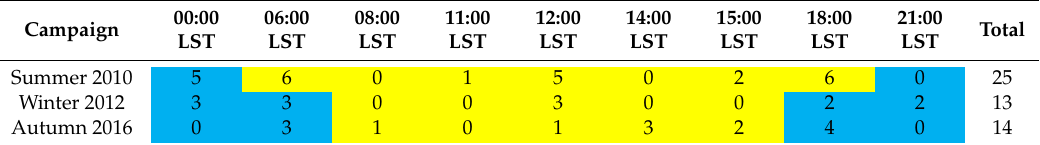
Table 1. Number and launching time of the soundings carried out during the campaigns. The color of the cells indicates the sunlight conditions during the radiosoundings (RS): yellow cells indicate diurnal RS, whereas blue cells indicate nocturnal